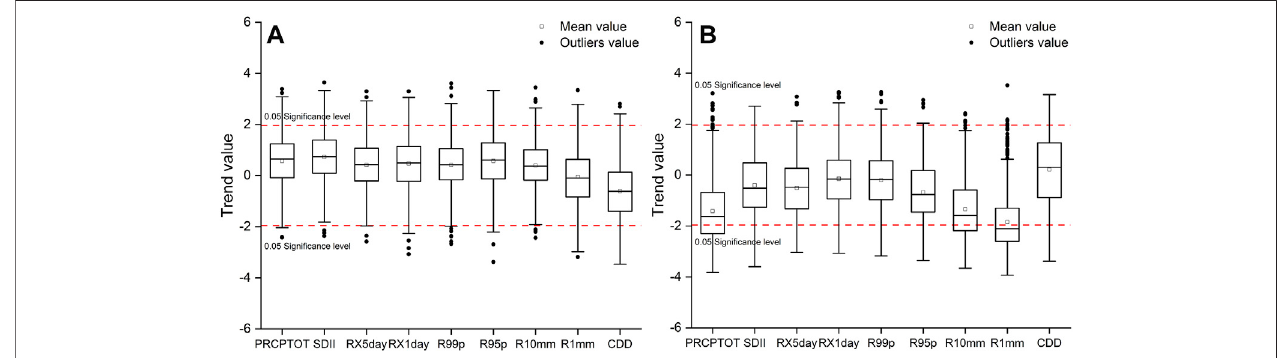
FIGURE 8 | Box plots of the PWMK test value of DISO for the Obs (A) and ERA5 (B) for extreme precipitation indices over China from 1979 to